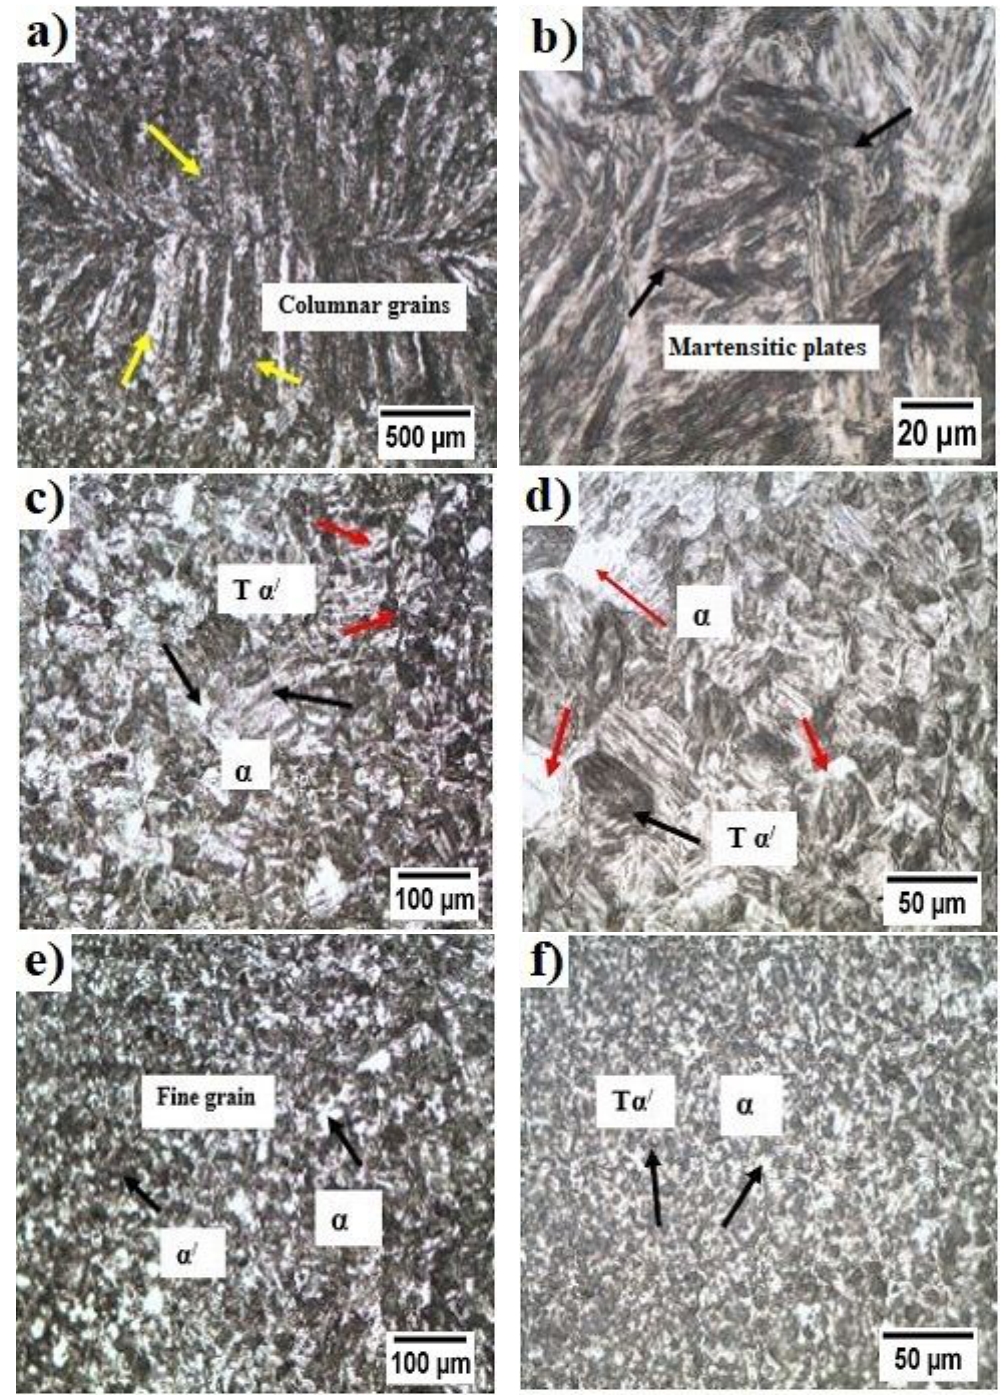
Figure 11: Optical microstructure of different regions of weld nugget of RSW AHSS-DP800 joints: a) NZ at 200X; b) NZ at 500X; c) CG-HAZ at 200X; d) CG-HAZ at 500X; e) FG-HAZ at 200X and f) FG-HAZ at 500X